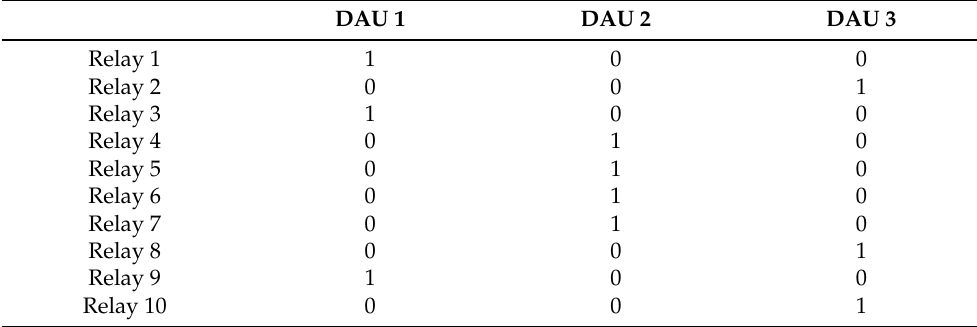
Table 2. DAU decision results under Scheme B.